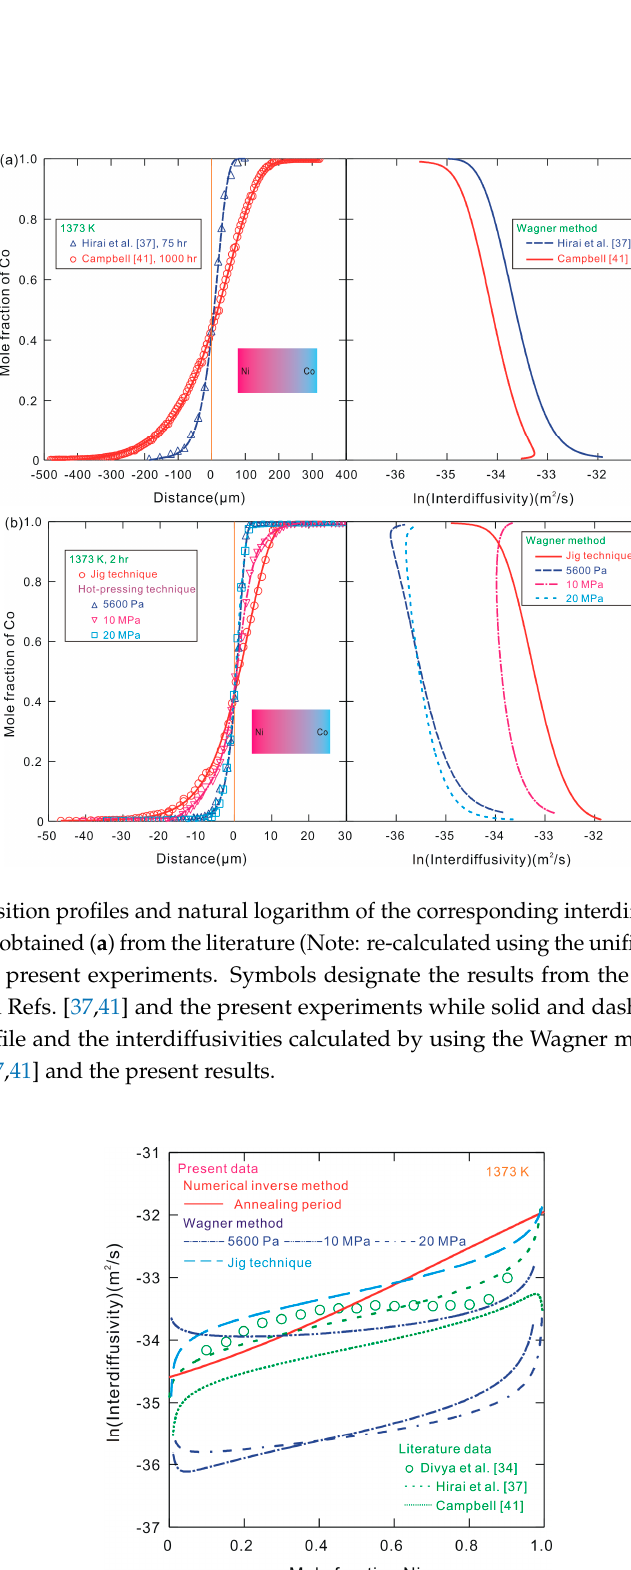
Figure 3. Natural logarithm of the interdiffusivities obtained by using the Wagner method and the pragmatic numerical inverse method in the binary Co–Ni system at 1373 K, compared with the literature data [34,37,41].